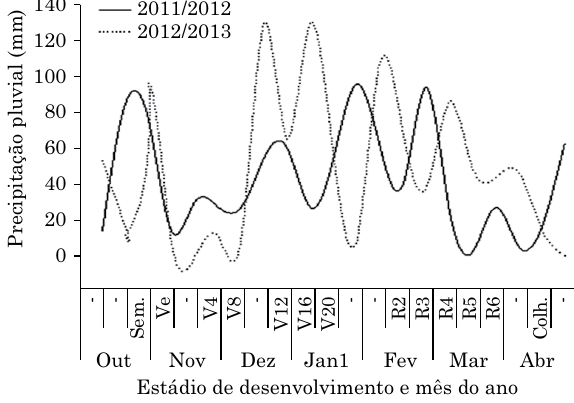
Figura 1. Precipitação pluvial para a cultura do milho nos anos agrícolas 2011/2012 e